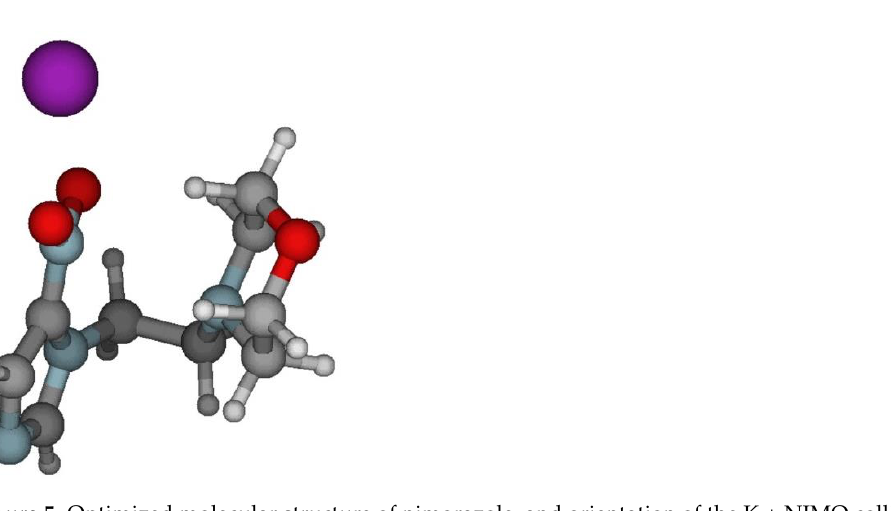
Figure 5. Optimized molecular structure of nimorazole, and orientation of the K + NIMO collisional system K − O ≈ 5.1 Å. K: yellow, O: red, C: grey, N: light blue, and H: white . See text for details.